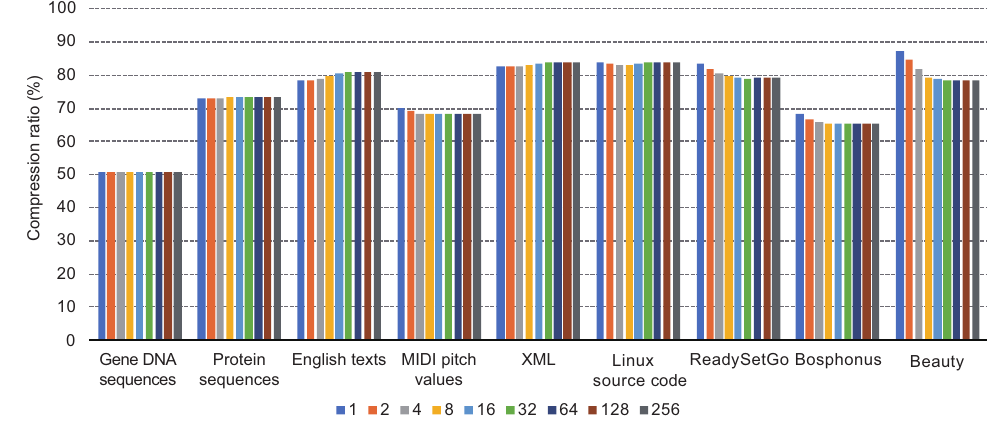
Figure 6. Comparison of compression ratios of ASE coding with varying the distance regarding the nearest neighbor entry exchange.